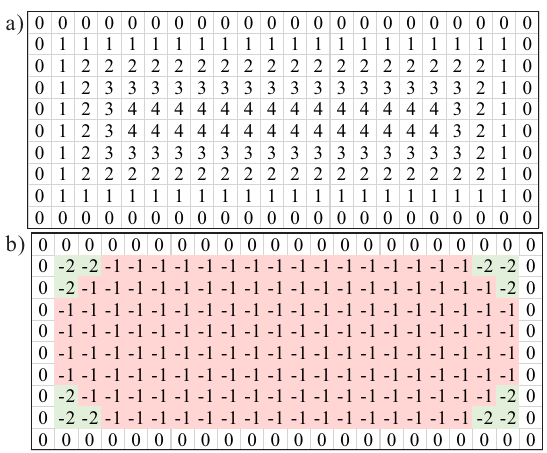
Figure 11. ( a ) Distribution of d on the rectangular cross section. ( b ) Partition of the rectangular cross section. The cross-sectional area of this rectangular tube is 8 × 20 μ m.